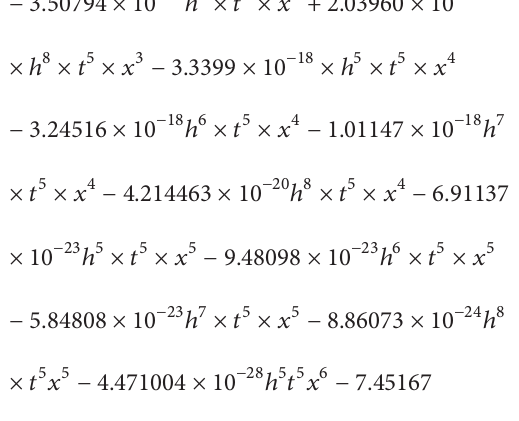
Figure 10: Three-dimensional plot for the solution of Saint Venant equations via homotopy analysis method obtained (a) 𝑦(𝑥,𝑡) = 𝑦 0 + 𝑦 1 + 𝑦 𝑦 𝑦 𝑦 𝑦 𝑦(𝑥,𝑡) = 𝑦 𝑦 2 + 3 + 4 + 5 + 6 + 7 (b)